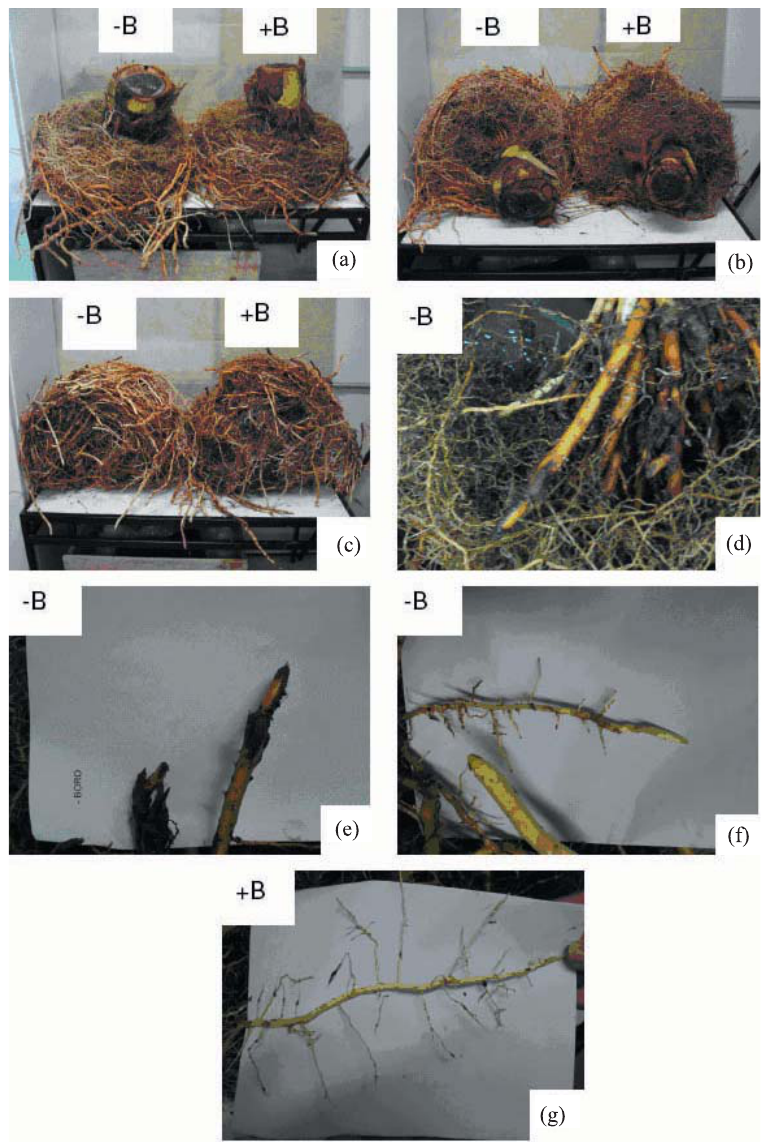
Figura 2. Sintomas visuais de deficiência de boro em raízes de coqueiro-anão verde. (a, b e c): imagens das raízes deficientes (–B) e normais (+B); (d) e (e): raízes com necroses e superbrotação; (f) e (g): raízes médias e finas nas plantas deficientes (-B) e normais (+B),